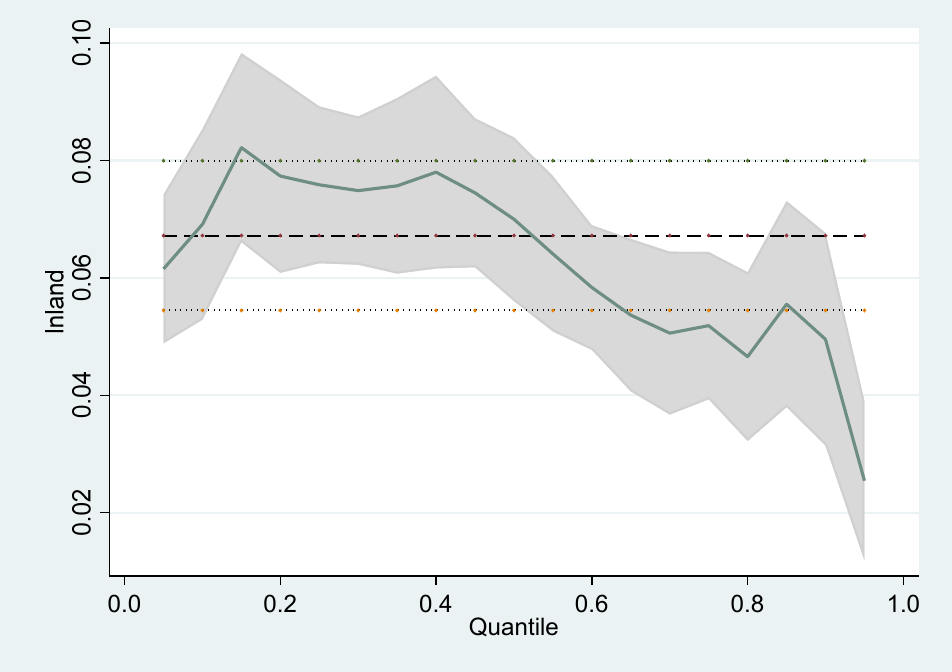
Figure 1. Marginal effects at different quantile levels. Note : (1) the green curve represents the estimated coefficients of lnland at different quantile levels, and the gray area represents the 95% confidence interval for the coefficient of lnland; (2) the black dashed line represents the estimated coefficient of lnland in the baseline model, and the area enclosed by the two light-colored dashed lines is the 95% confidence interval for the coefficient of lnland in the baseline model.